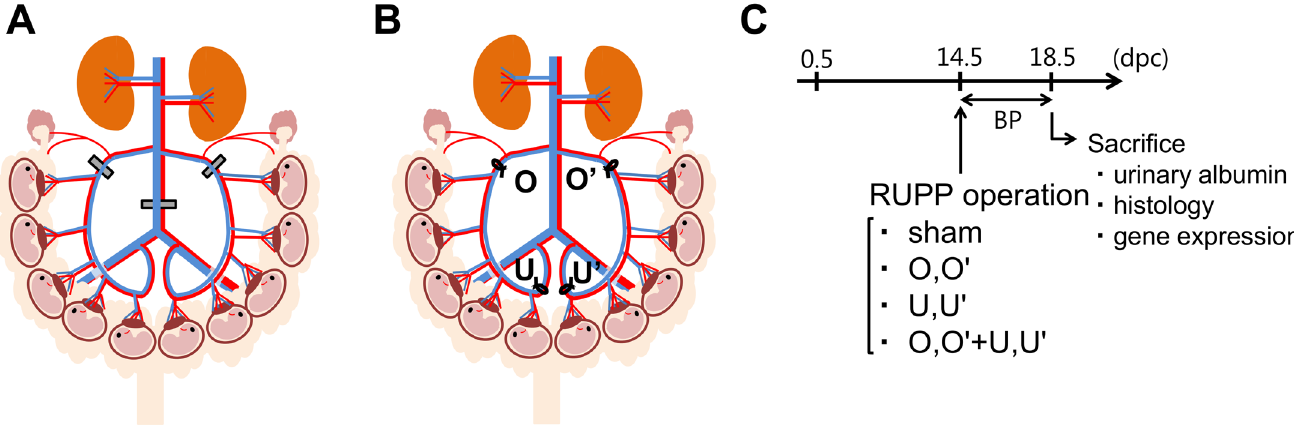
Fig 1. Comparison of conventional reduced uterine perfusion pressure (RUPP) model and novel RUPP model. ( A ) Conventional RUPP model in rats. Silver clips are placed around the aorta right above the iliac bifurcation and around the left and right uterine arcade at the ovarian artery before the first segmental artery. ( B ) Novel RUPP model in mice. At 14.5 dpc, a midabdominal incision was made and a ligature was tied around the uterine arterial and venous branches of the vascular arcade at either ovarian vessels (O,O ’ ) or uterine vessels (U,U ’ ). ( C ) Experimental design.